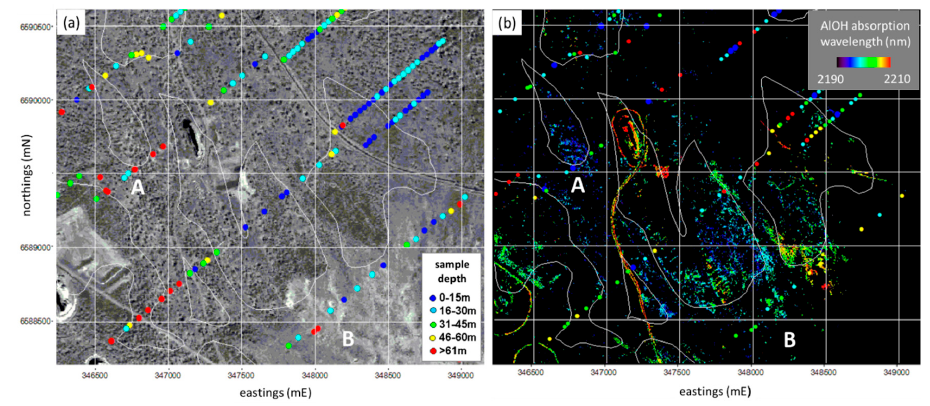
Figure 10. Regolith-alteration maps of the Binduli area, ~15 km WSW of Kalgoorlie, Western Australia (see Figure 9). ( a ) Airborne HyMap™ B&W visible image together with drill-core locations that are color coded to show “depth to fresh rock” (Figure 1). White polygons show float/subcrop of felsic volcaniclastic rocks [102]—all other areas, except mine workings, are published as alluvium/colluvium and lacustrine sediments; ( b ) Airborne HyMap™ image of white mica composition, masked to remove all pixels with detectable 2160 nm kaolin absorption, together with similarly processed bottom-of-hole fresh rock spectral measurements.